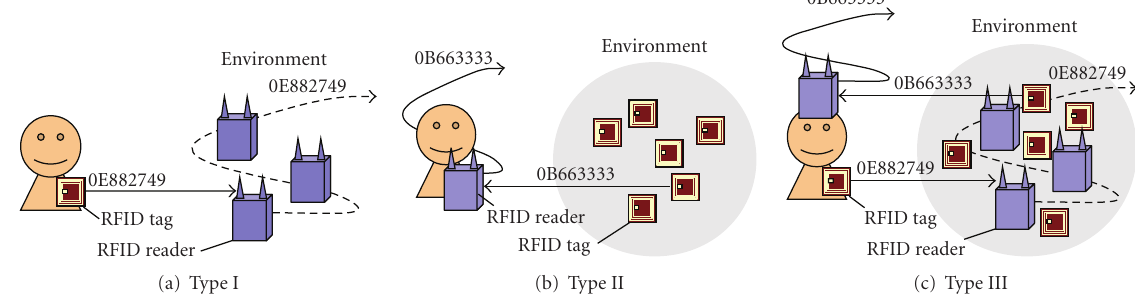
Figure 3: Information